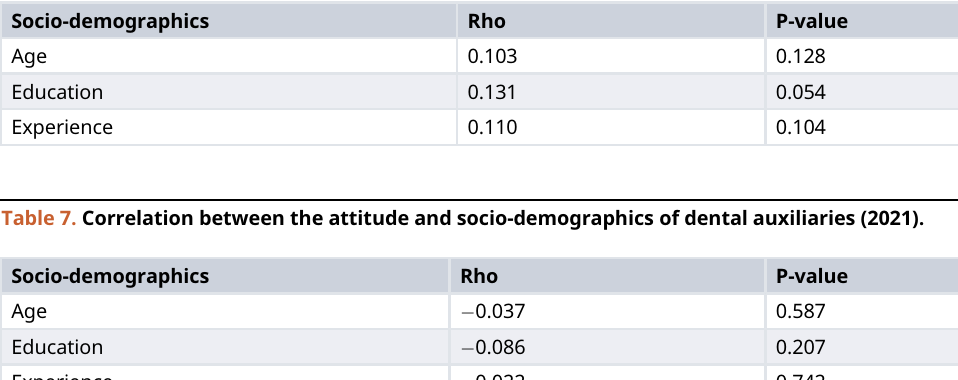
Table 6. Correlation between the knowledge and socio-demographics of dental auxiliaries (2021).